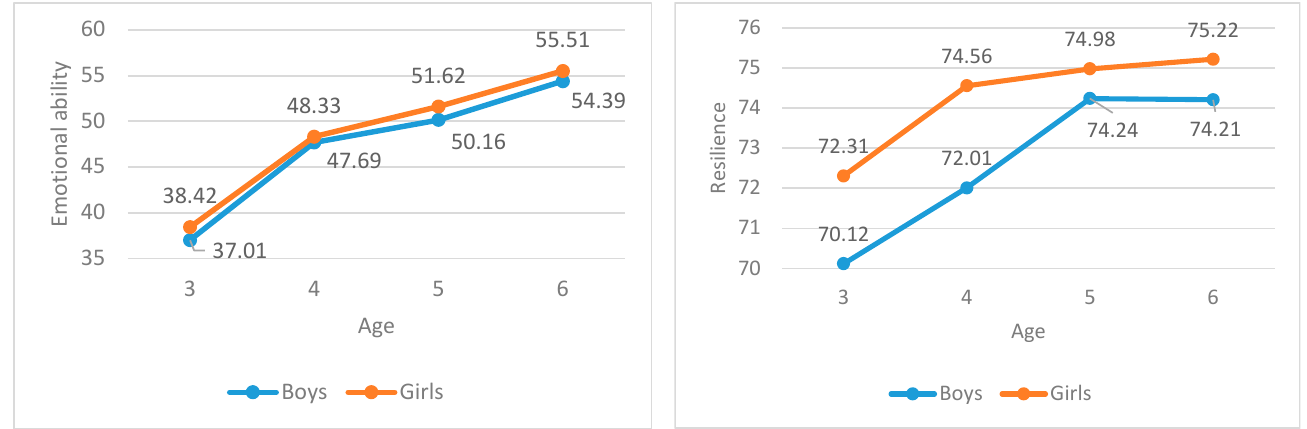
Figure 2. Age and gender differences in emotional ability and resilience.